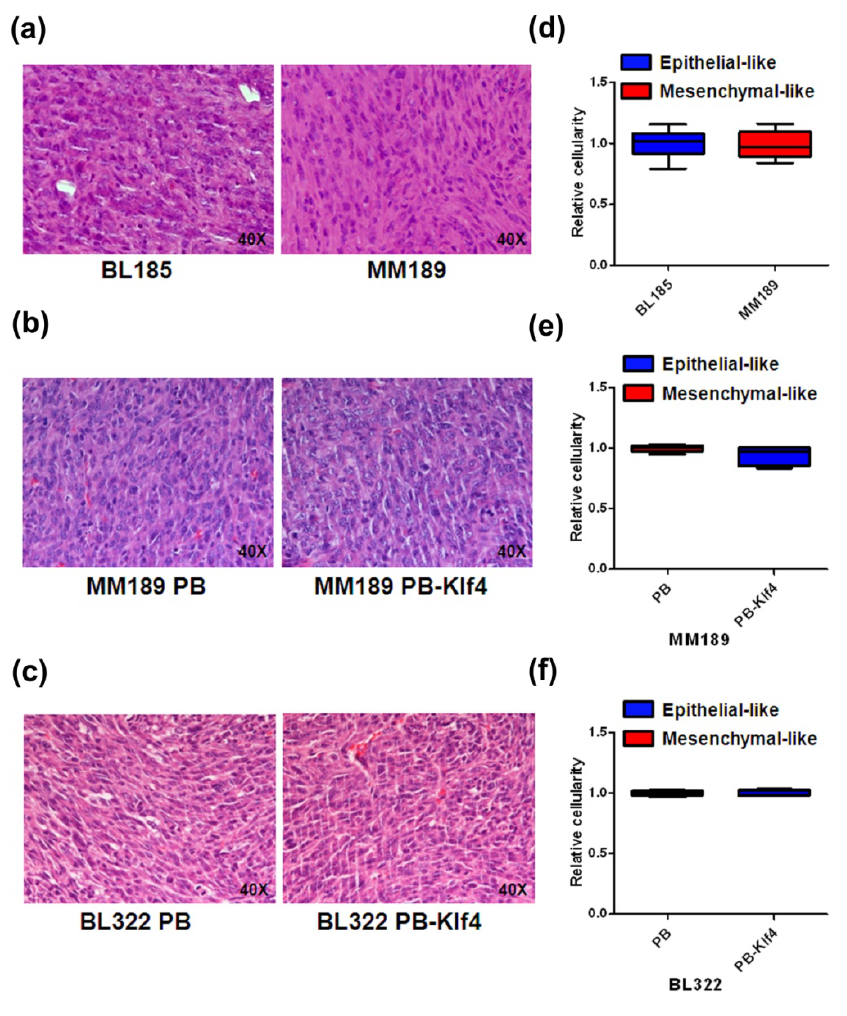
Figure 5. Representative hematoxylin and eosin (H&E) staining and tumor cellularity analysis. H&E-stained images (400×) of subcutaneous tumors from ( a ) BL185 and MM189; ( b ) MM189 PB and MM189 PB-Klf4; and ( c ) BL322 PB and BL322 PB-Klf4 tumors showed similar tumor cellularity. Graphs show quantitative measurement of the cellularity of ( d ) BL185 and MM189; ( e ) MM189 PB and MM189 PB-Klf4; and ( f ) BL322 PB and BL322 PB-Klf4 subcutaneous